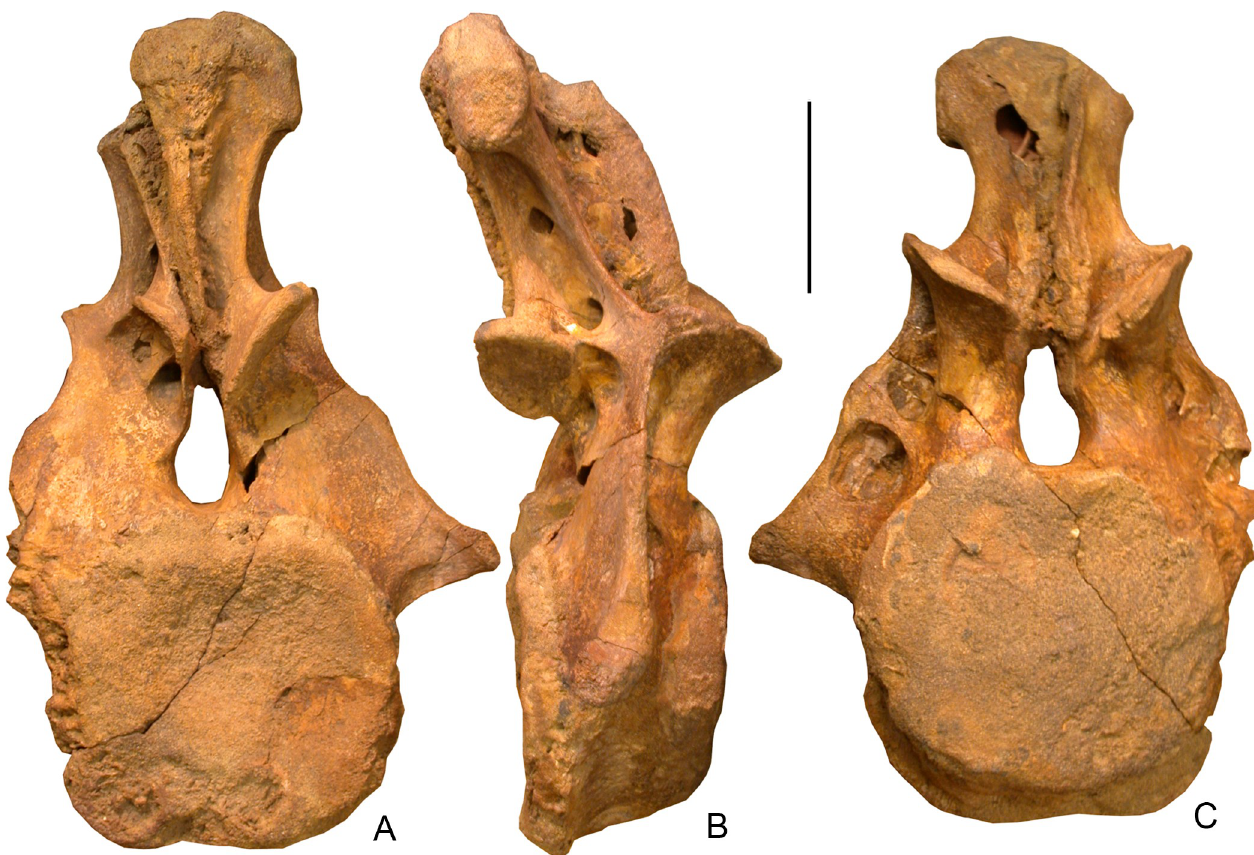
Fig 1. Dzharatitanis kingi , USNM 538133 (holotype), anterior caudal vertebra in posterior (A) , right lateral (B) , and anterior (C) views. Scale bar = 10